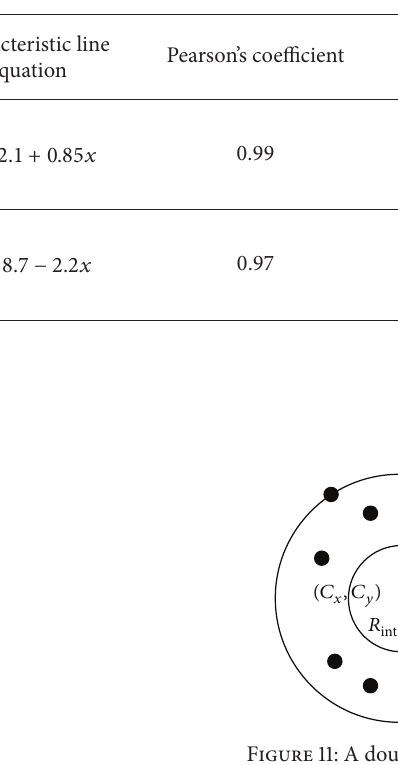
Table 1: Applying our model to the formation in Figure 9.